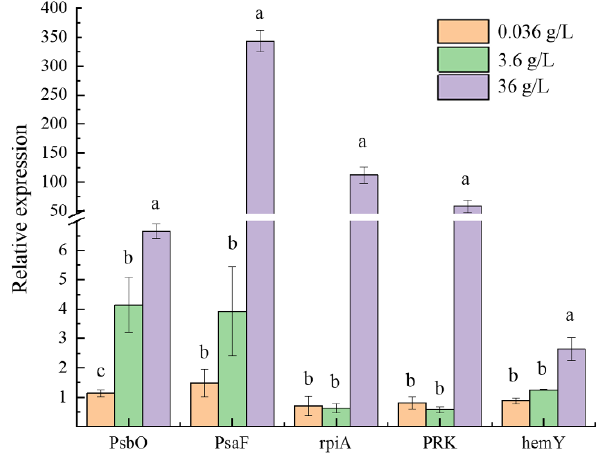
Figure 18. Relative expression levels of related metabolic pathway genes in the 0.036 g/L CaCl 2 group and the 36 g/L CaCl 2 group (The letters a and b indicate the significance of the difference).